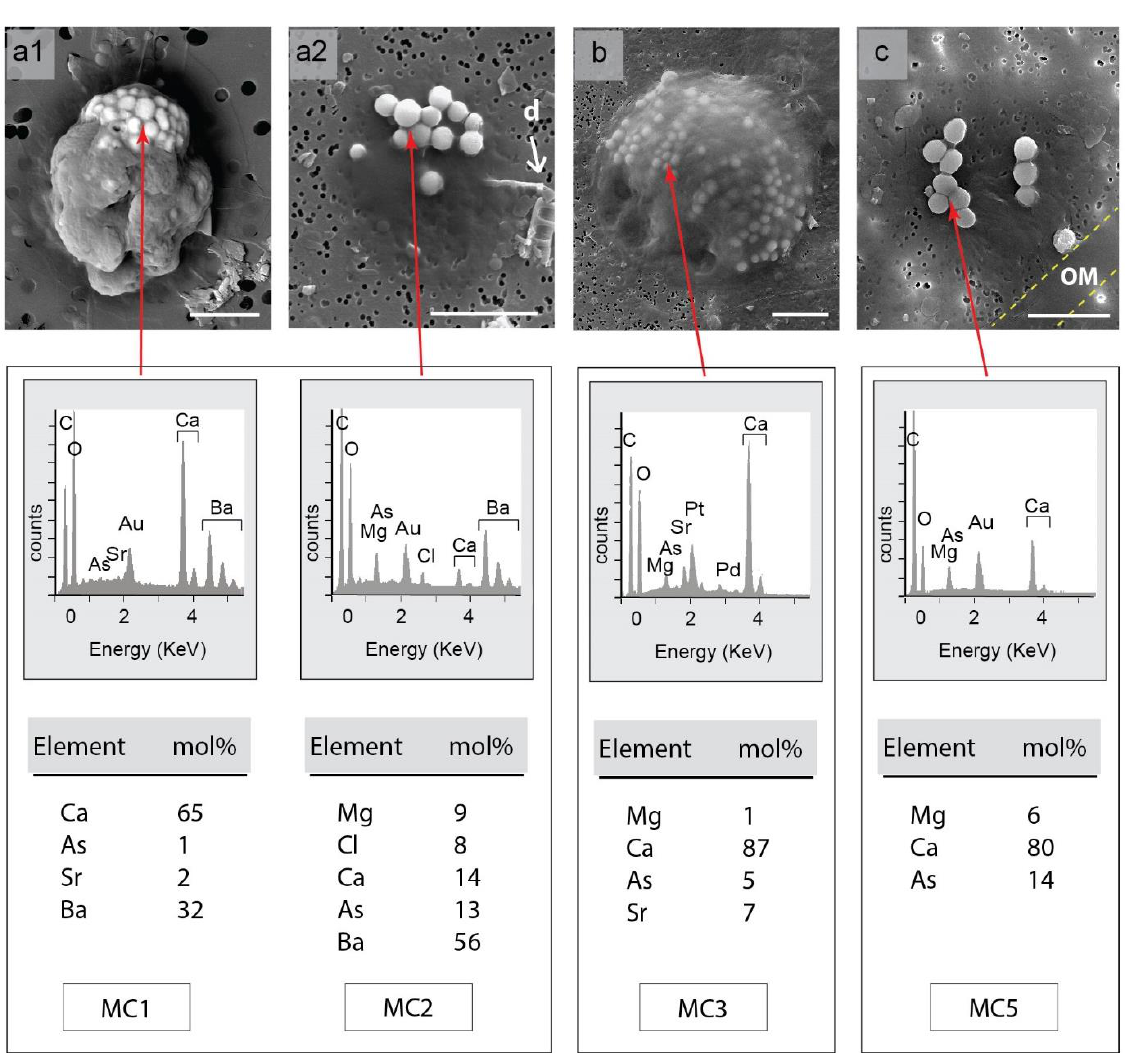
Figure 1. Specimens of the four types of micropearls incorporating As in Lake Geneva. All are secondary-electron SEM images of dried filters except ( a1 ): backscattered SEM image of a dried sample fixed with glutaraldehyde. Micropearls appear white or light grey against the darker organic matter. Elements linked to sample coating were not taken into account in the calculations: Au ( a , c ) and Pt/Pd ( b ). Whole spectra of samples are shown in Figure S4. Pores of the filters appear as small black dots. Water samples were taken from Lake Geneva at GE3 location on ( a1 ) 10.07.2018, cumulative sample between 0 and 50 m, ( a2 ) 14.06.2016, 10 m, ( b ) 06.08.2013, 10 m depth, ( c ) 19.05.2015, 18 m. d: diatom frustule fragments. OM and yellow dotted lines: unrelated organic matter. Scale bars: 5 µm.